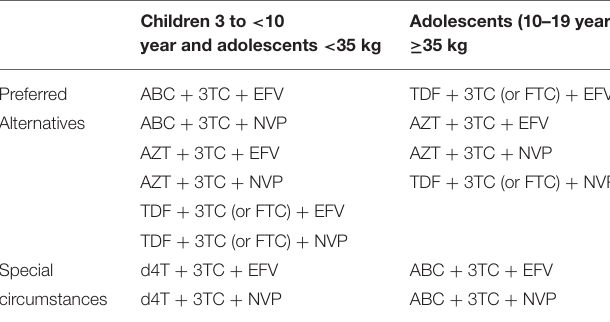
TABLE 1 | Summary of recommended first-line ART regimens for children and